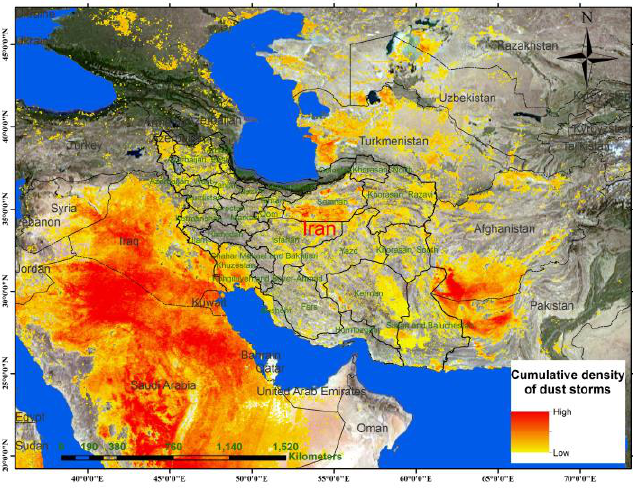
Figure 3. Cumulative density map